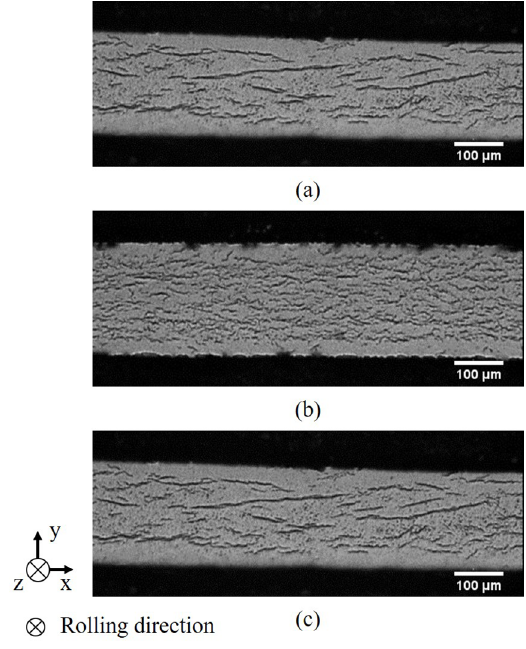
Figure 7. Transversal section of plates after electrolytic hydrogenation for 72 h showing hydride distribution and orientation for (a) Zr- 0.9Nb-0.1Mn, (b) Zr-0.8Nb-0.2Mn and (c) Zr-0.6Nb-0.4Mn.